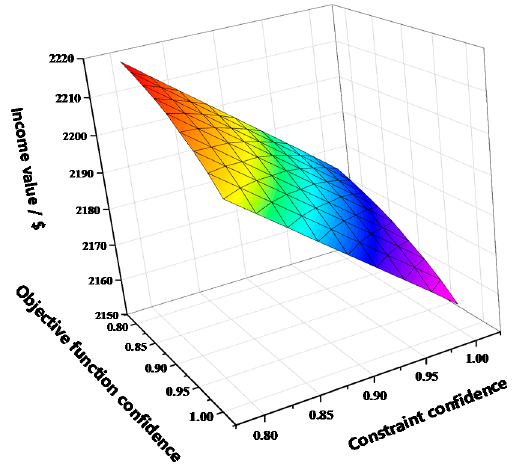
Figure 11. The curve diagram of the microgrid’s day-ahead market returns under different levels.